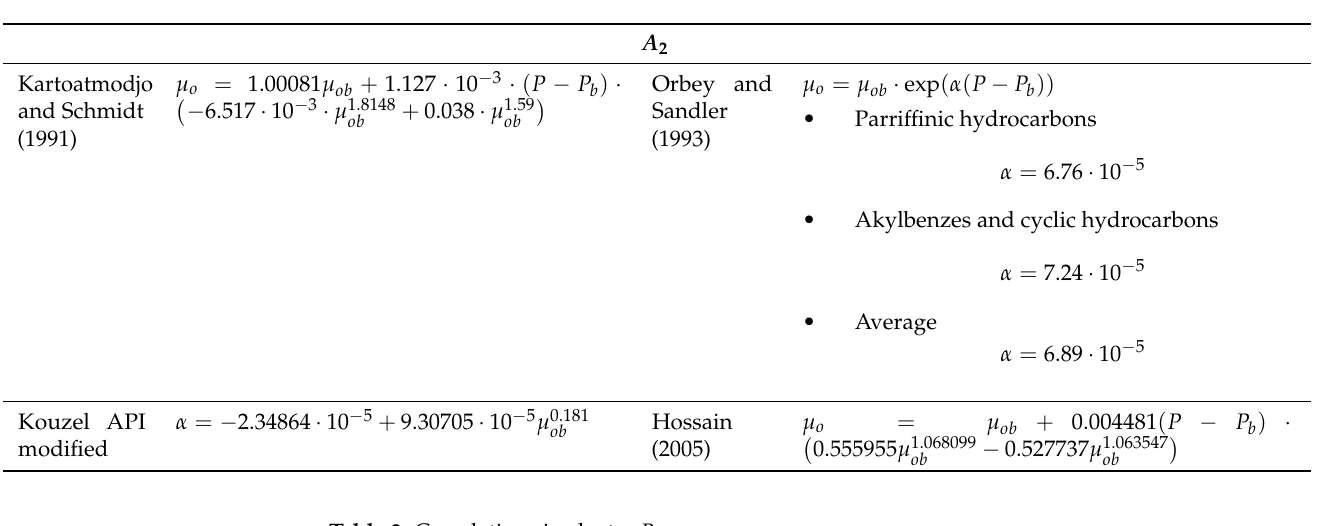
Table 2. Correlations in cluster A 2 .